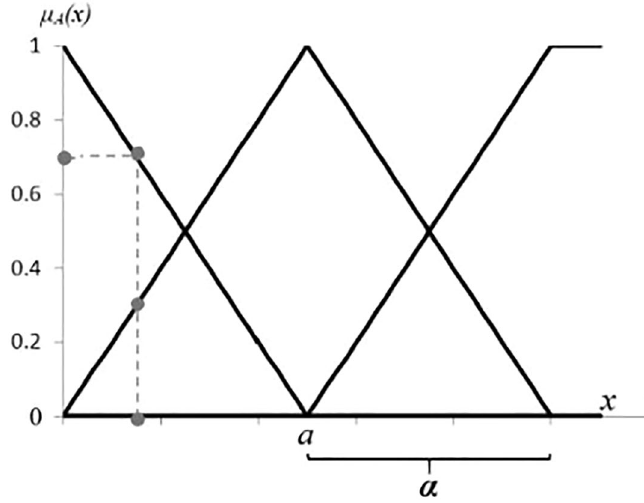
Figure 1. Symmetric triangular membership